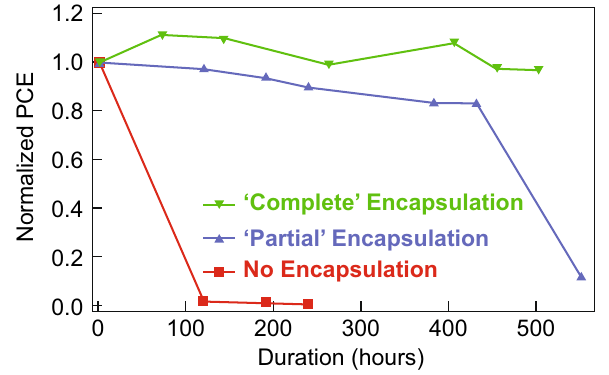
Fig. 18 Normalized I – V parameter of nonencapsulation, partial encapsulation, and complete encapsulation perovskites. Reproduced with permission Ref. [195]. Copyright (cid:2) 2015 Elsevier